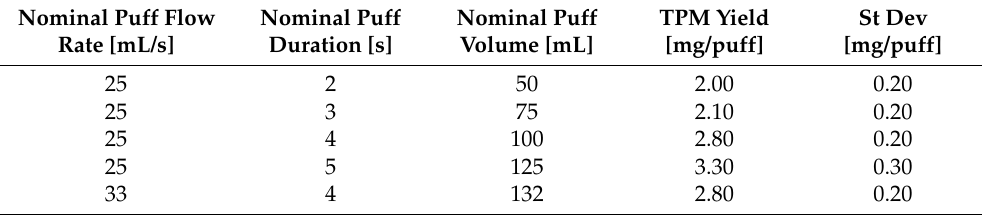
Table 1. Son et al. [1] reported yield per puff with three repeated trials per condition for JUUL ENDS filled with Fruit Melody E-Liquid having a manufacturer-reported nominal nicotine concentration of 59 [mg/mL]. The underlying data reported by Son was extracted and converted into the nomenclature and units of the current article in order to provide a basis for comparison with results presented